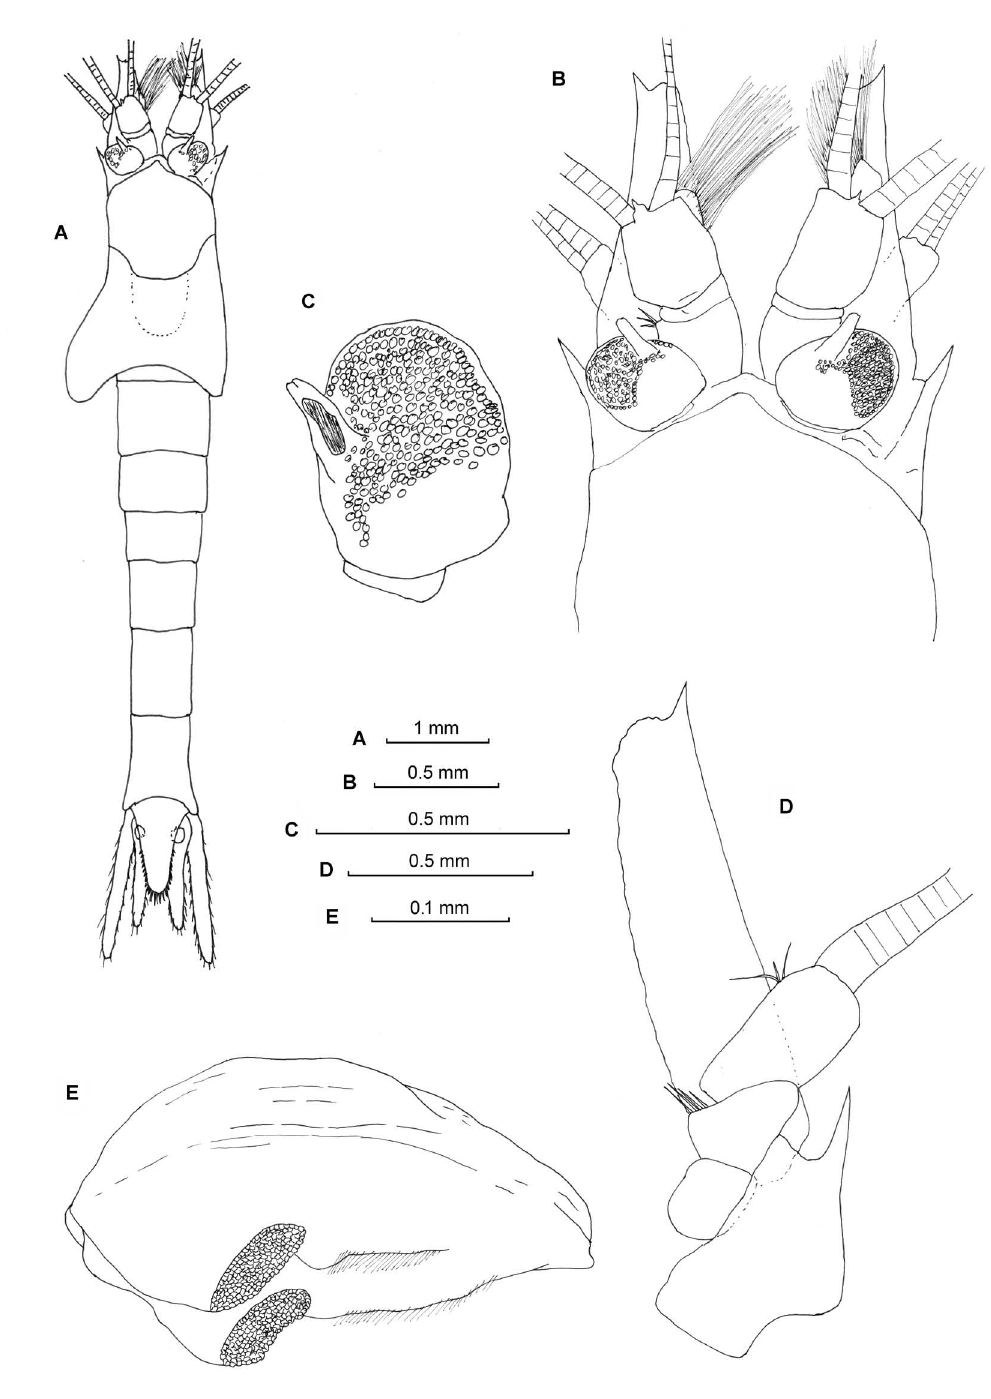
Fig . 1. – Dactylamblyops corberai n. sp.; holotype, mature male: A, habitus in dorsal view; B, anterior portion in dorsal view; C, eye; D, antenna in ventral view; E,